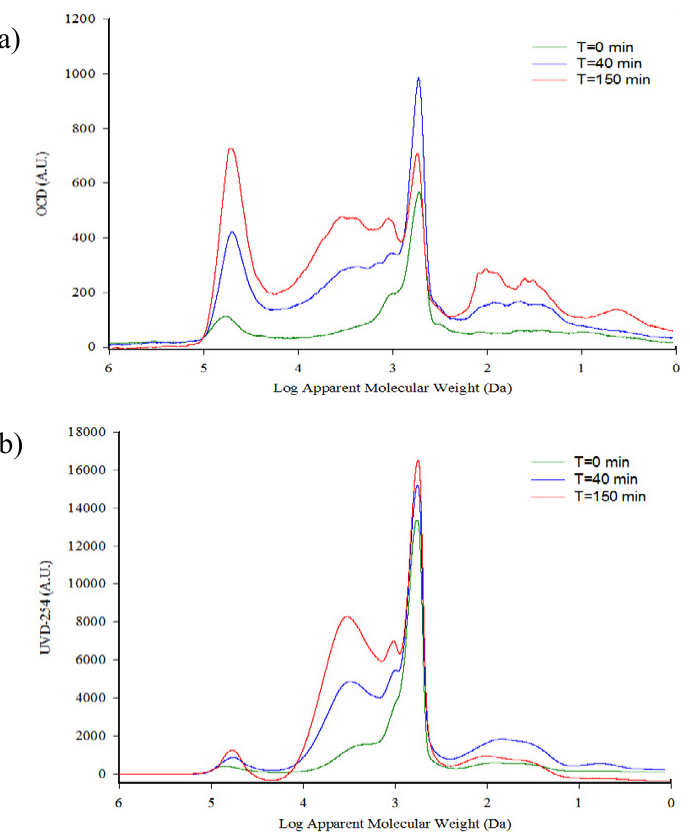
Fig. 2: Distribution of organic fractions as detected by HPSEC with (a) OCD and (b) UVD in water contained of ammonia nitrogen of 5